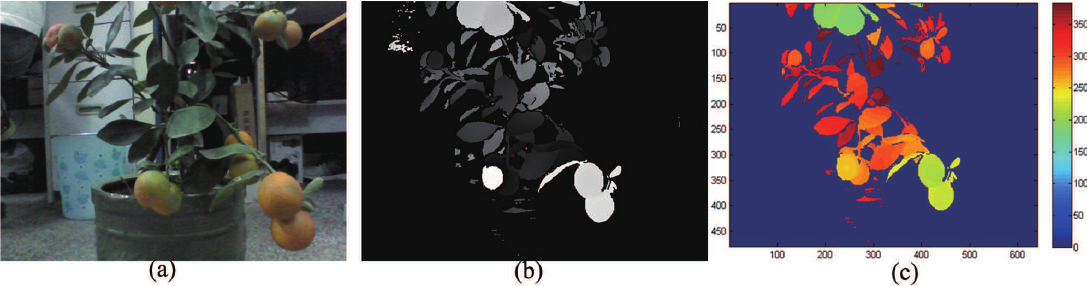
Figure 4. A depth-point cloud of a kumquat plant captured by RealSense F200: ( a ) color image; ( b ) depth image; ( c ) rendered depth